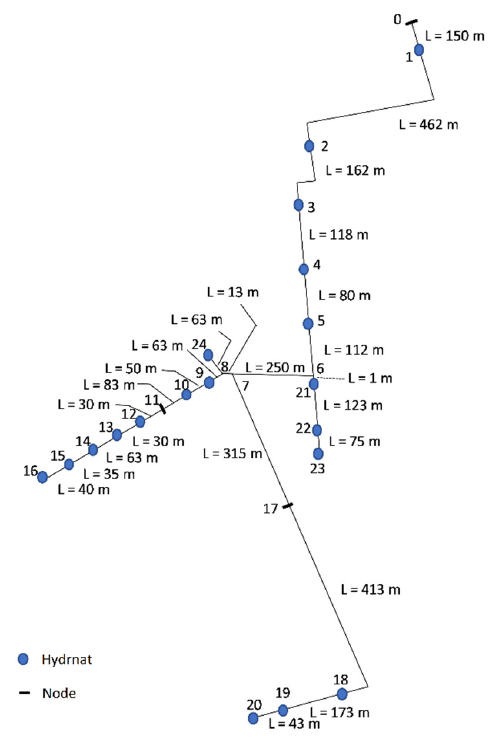
Figure 4. The Sinistra Ofanto irrigation scheme.